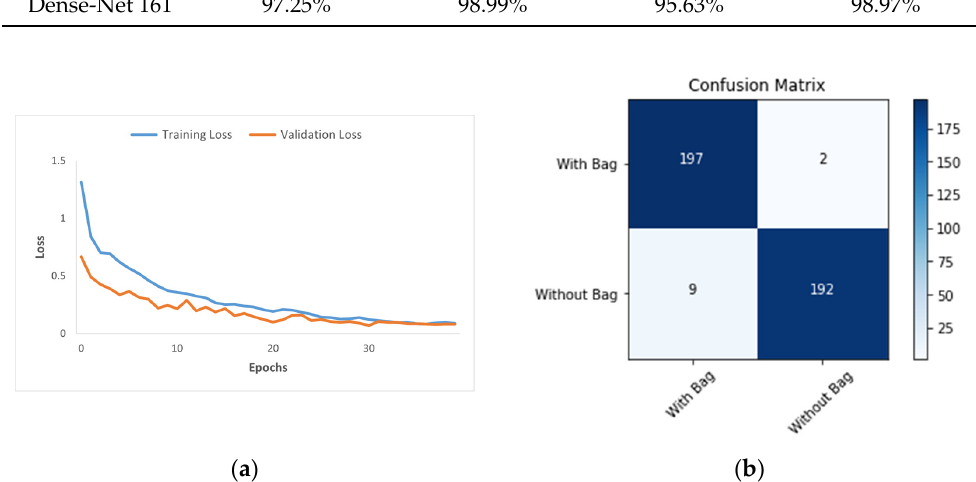
Figure 7. The loss curve and confusion matrix of the second experiment on INRIA and MSMT17 datasets: ( a ) The loss curve, ( b ) the confusion matrix. INRIA, ILIDS, and MSMT17 Datasets Results